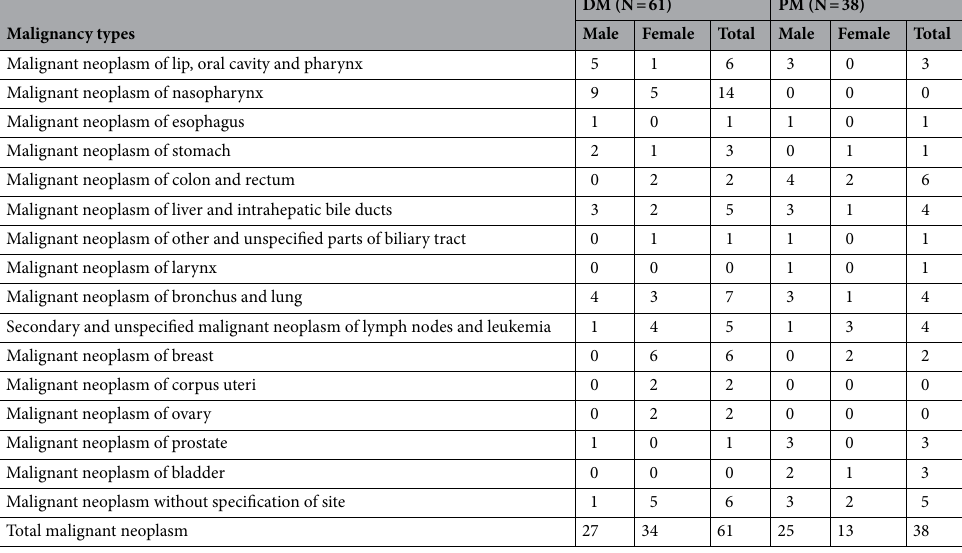
Table 2. Malignancy types occurred in patients with DM and PM. DM dermatomyositis, PM